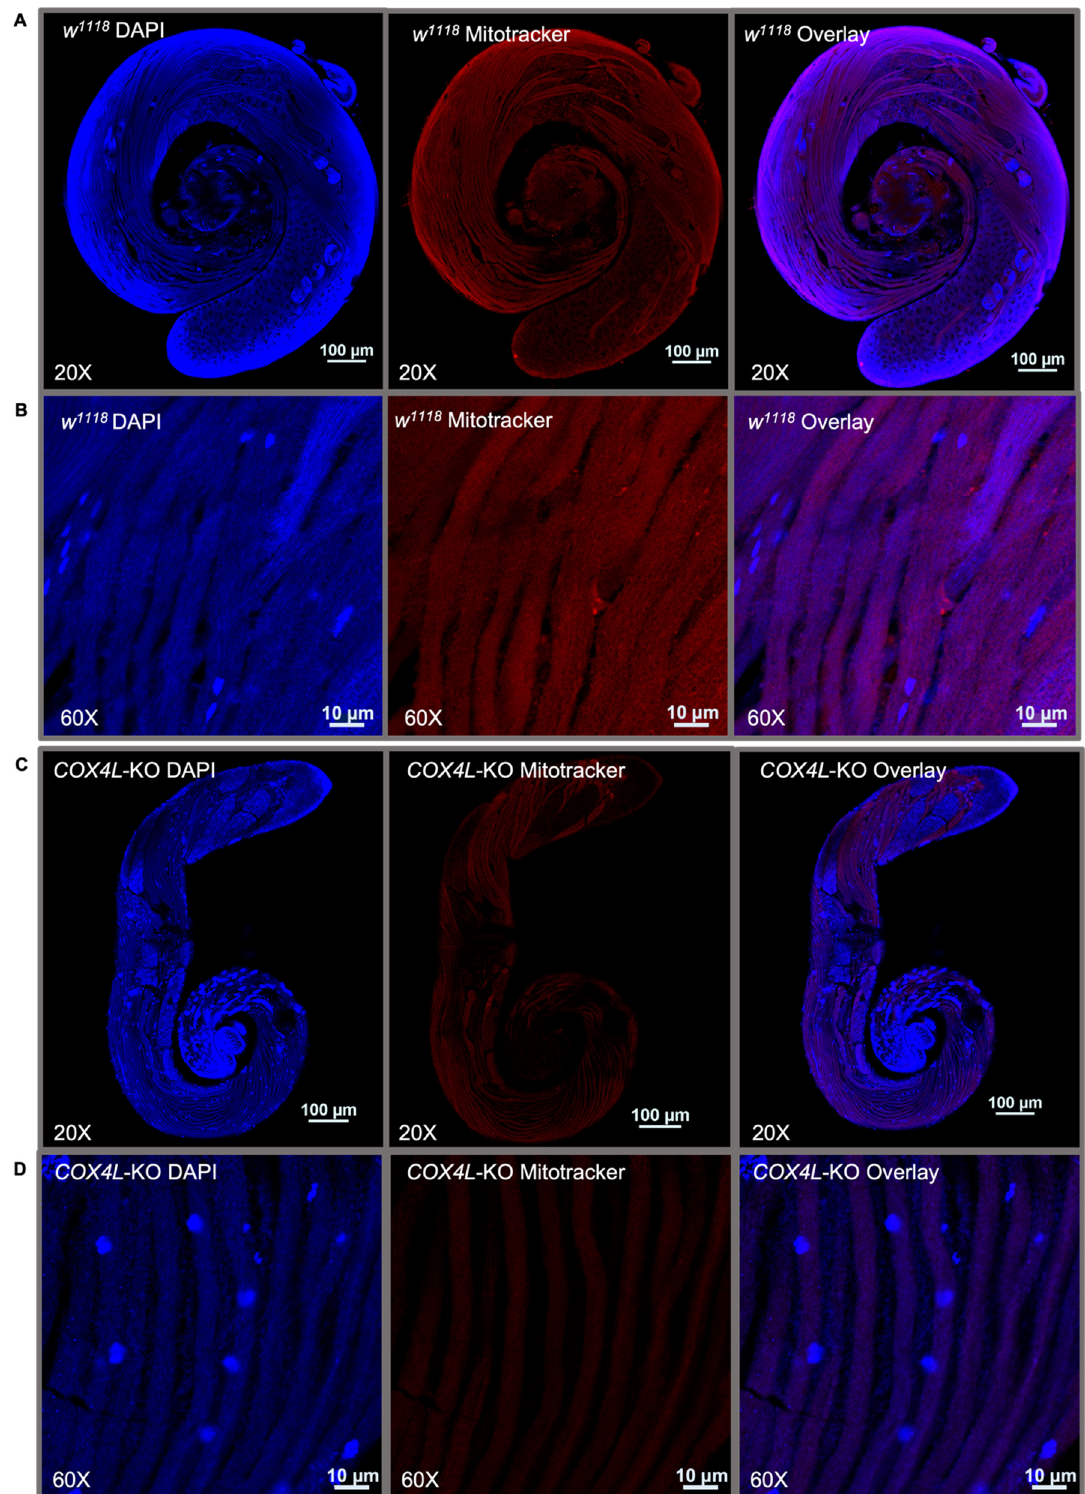
Figure 4. One-day-old male testes of ( A , B ) w 1118 and ( C , D ) COX4L -KO stained with MitoTracker™ Deep Red FM and DAPI. Sperm bundles stained with MitoTracker in ( B ) COX4L -KO show less fluorescence compared to ( D ) w 1118 , due to reduced mitochondrial membrane potential and/or mitochondrial morphology changes (Supplementary Figure S2).